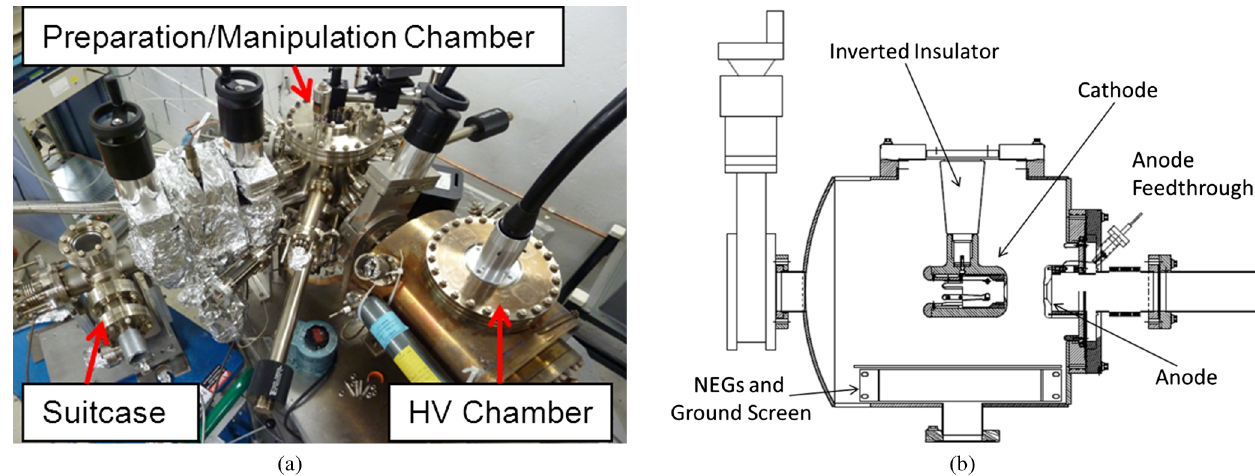
FIG. 4. Photograph (a) and schematic view (b) of the dc high voltage photogun at